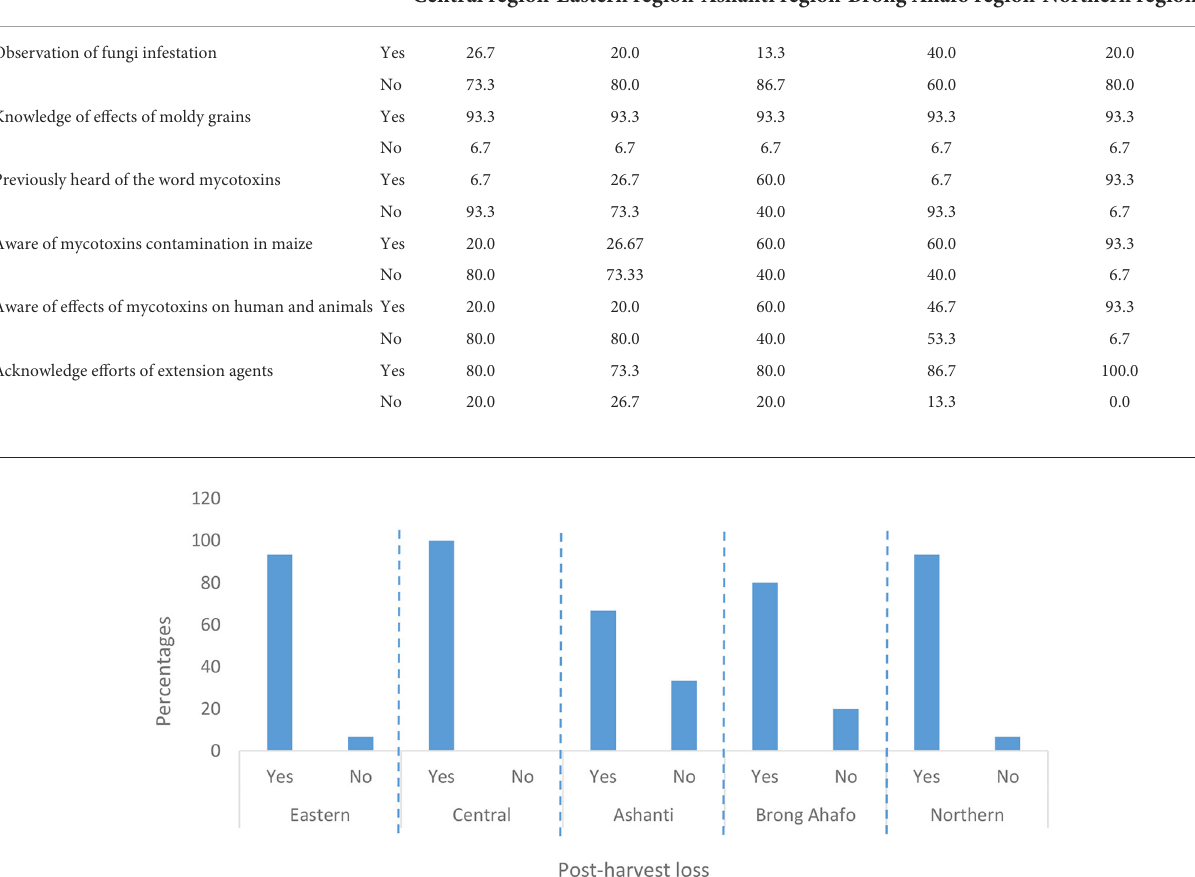
TABLE 8 Farmers’ knowledge of mycotoxins, and acknowledgment of AEAs’ activities. Parameter